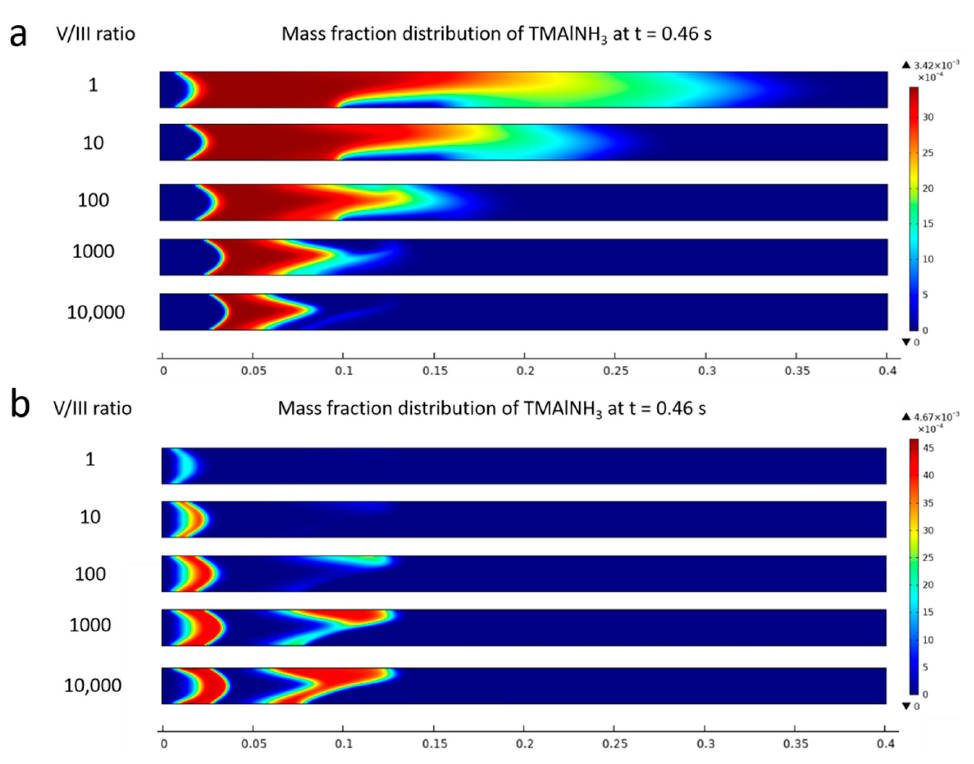
Figure 6. Mass fraction distributions of ( a ) TMAl and ( b ) TMAlNH 3 at 0.46 s for different V/III ratios.